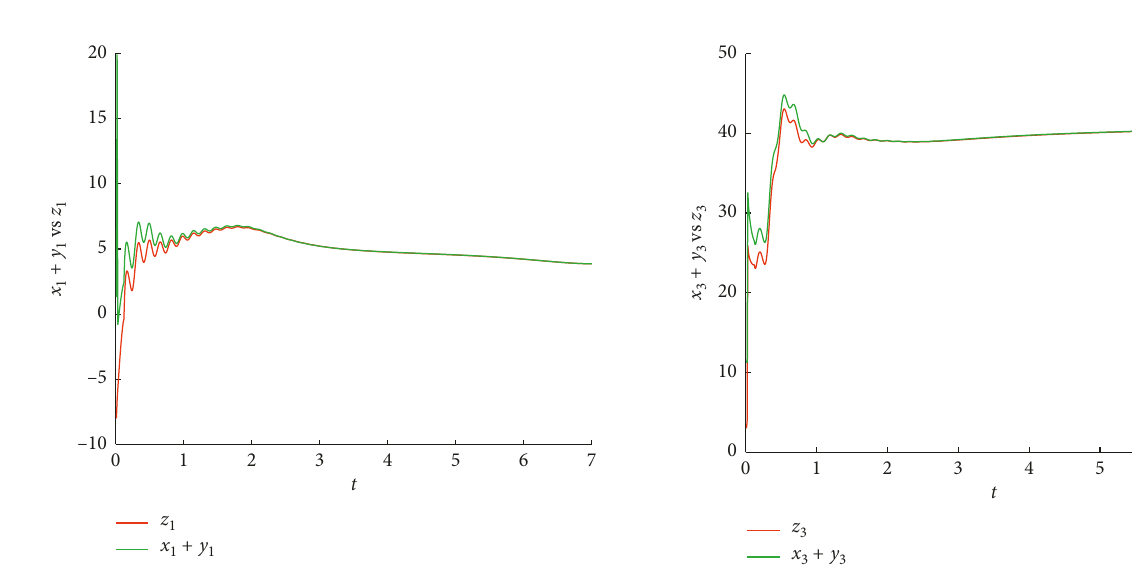
+ y versus z 2 2 2